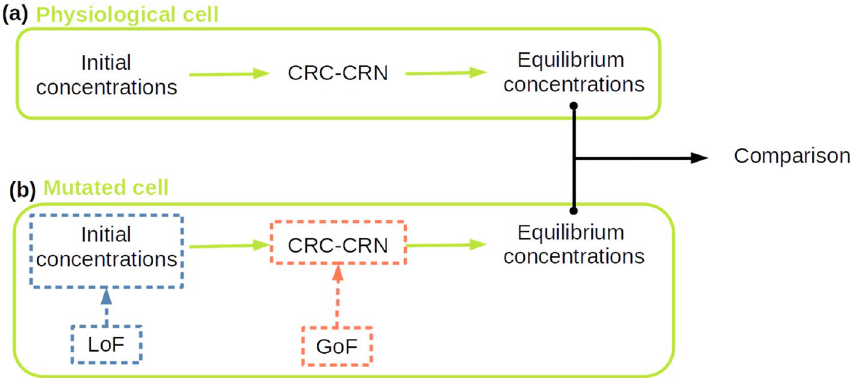
Figure 1. General workflow of the CRC–CRN. ( a ) The values of the protein concentrations at the equilibrium in the physiological cell are computed by integrating the system of ODEs defining our CRC–CRN. ( b ) Any mutation resulting in the loss of function (LoF) of a protein is embedded in our model by modifying the values of the conserved moiety in input. Conversely, mutations causing gain of function (GoF) are implemented